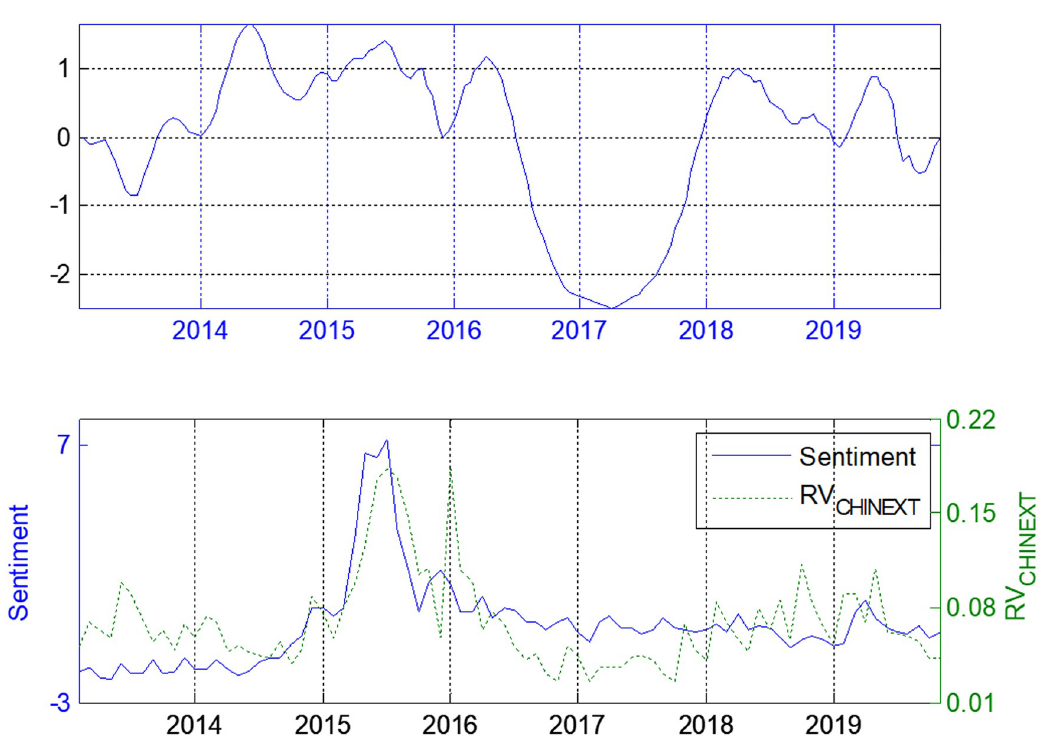
Fig 5. Lead-lag structure for investor sentiment and ChinNext Price